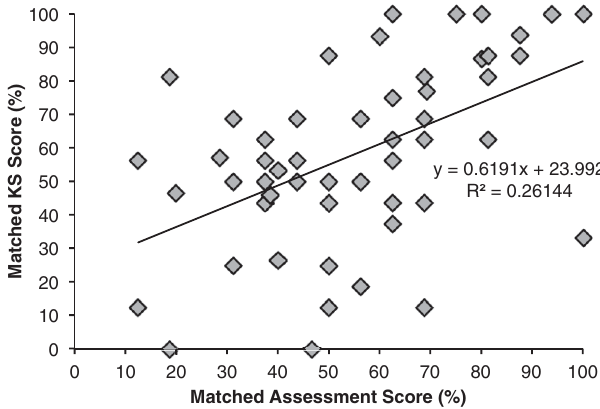
FIG. 2. Scatterplot of students ’ KS-matched scores versus their actual scores on the matched assessment items for Physics 211.